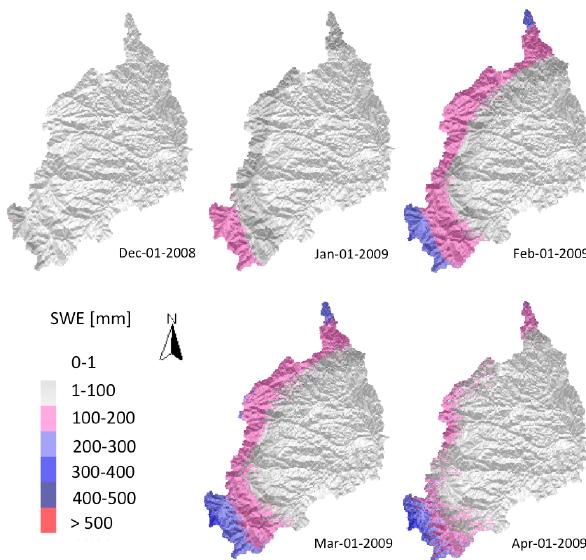
Fig. 8. SWE-C application in distributed mode: snow water equiva- Figure 8. SWE-C application in distributed mode: snow water equivalentmapsfrom1Novemberto1JunefortheUpperCachela Poudrebasin. lent maps from 1 November to 1 June for the upper Cache la Poudre